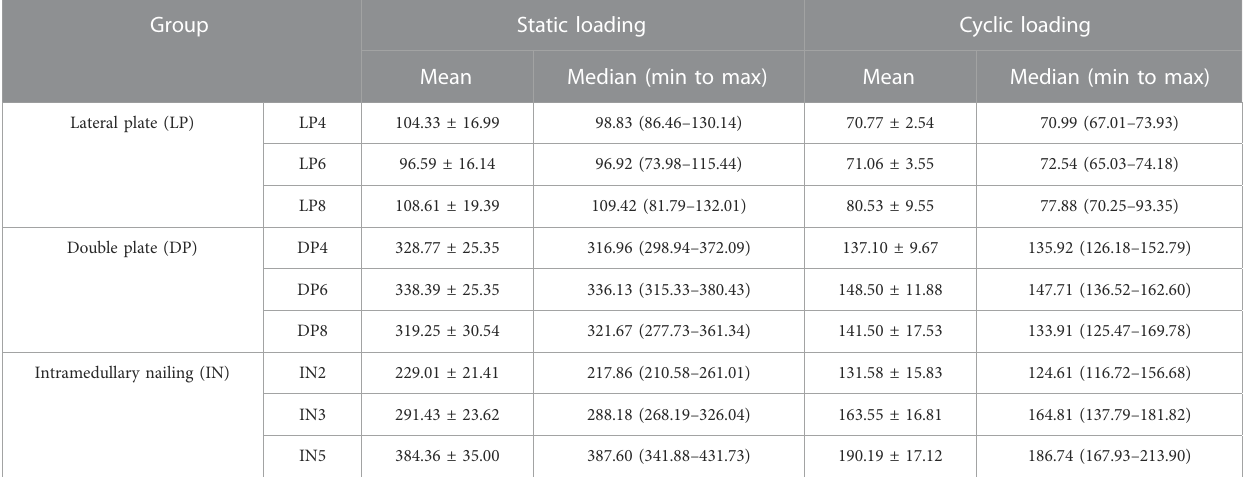
TABLE 1 Mean stiffness in N/mm of each group and standard